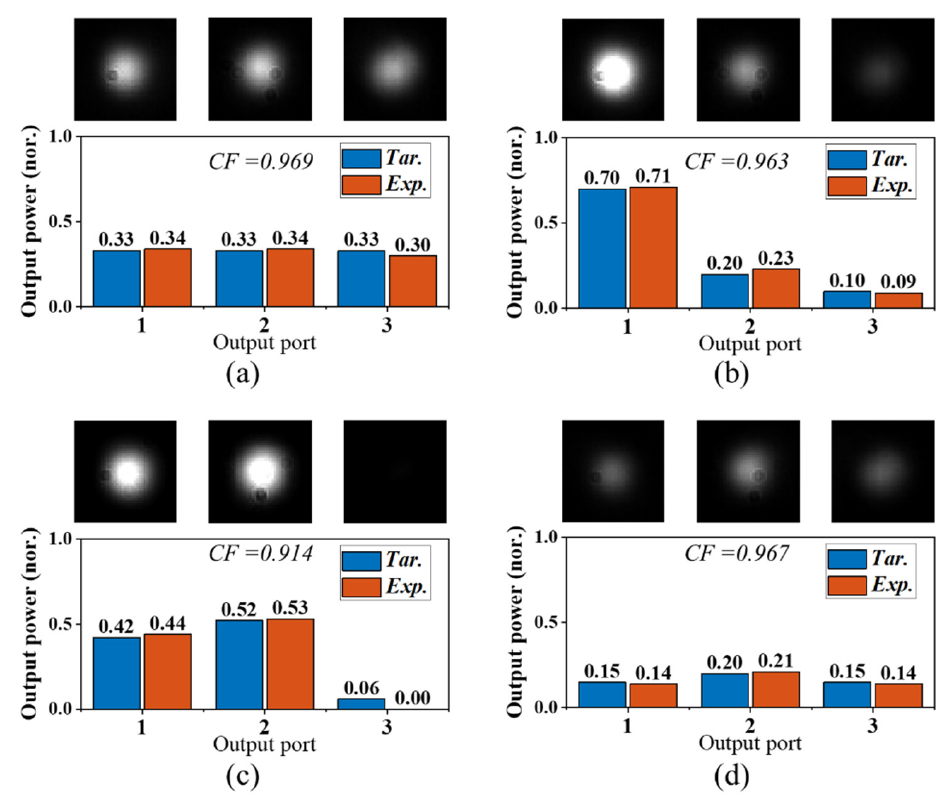
Figure 7. The experimental output spots and their comparisons with the targets of ( a ) [0.33:0.33:0.33] , ( b ) [0.70:0.20:0.10] , ( c ) [0.42:0.52:0.06] , and ( d ) [0.15:0.20:0.15] . The power values are normalized to the total output power at the initial state. The sum is 1 for lossless splitting, and the sum is <1 when extra attenuation is added.